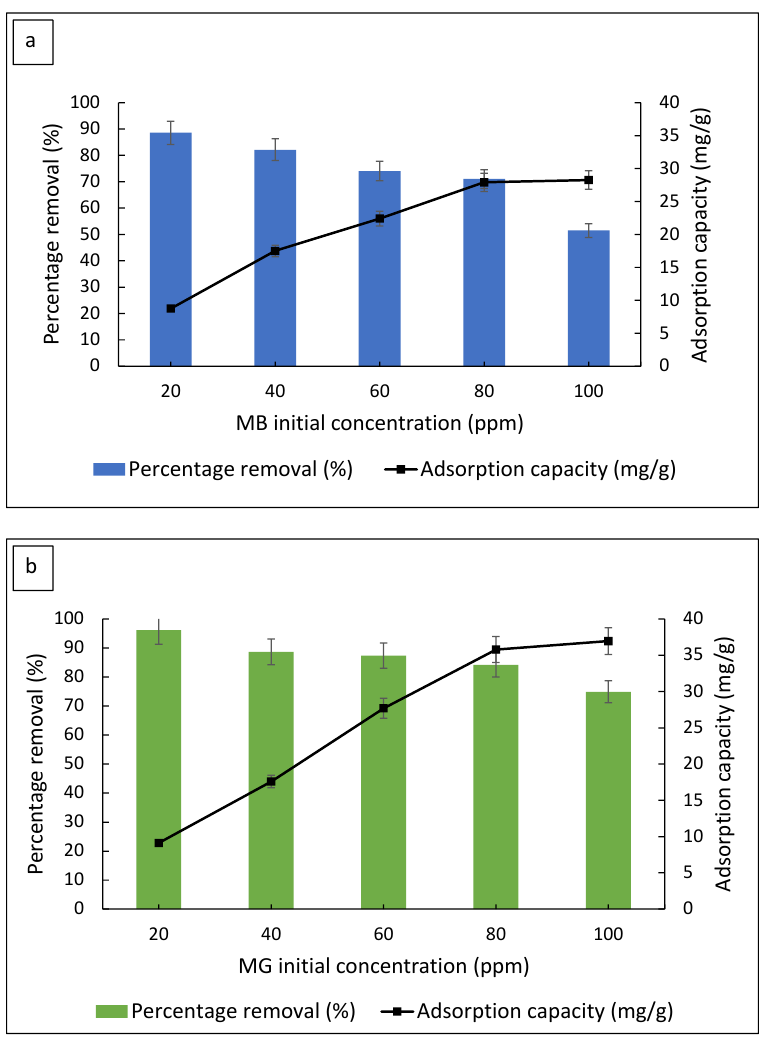
Figure 8. The effect of the initial dye concentration on the percentage removal and adsorption capacity for ( a ) MB and ( b ) MG.